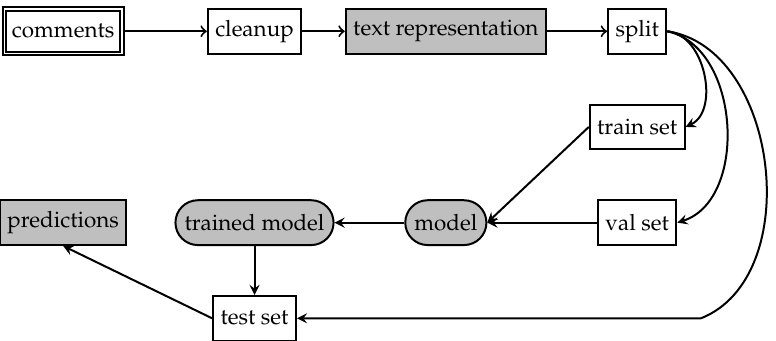
Figure 1. Classification pipeline for monolingual setting.